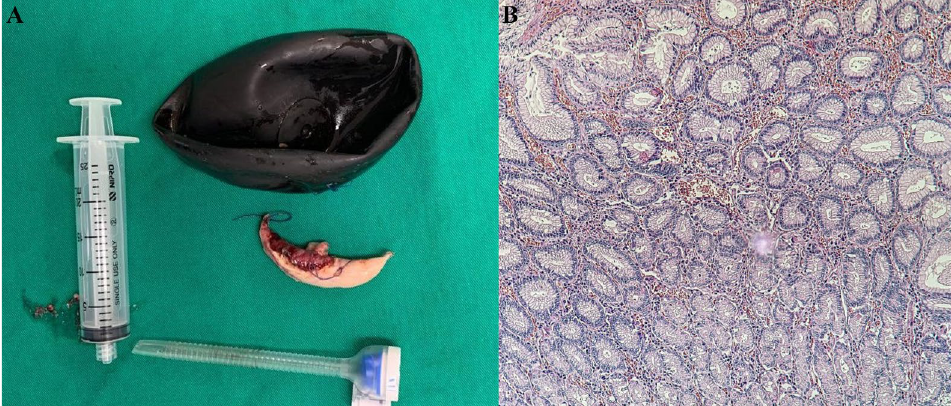
Fig. 3 A Gastric balloon and ulcer are removed. B Pathology, Inflammation with necrosis, and cellular debris was